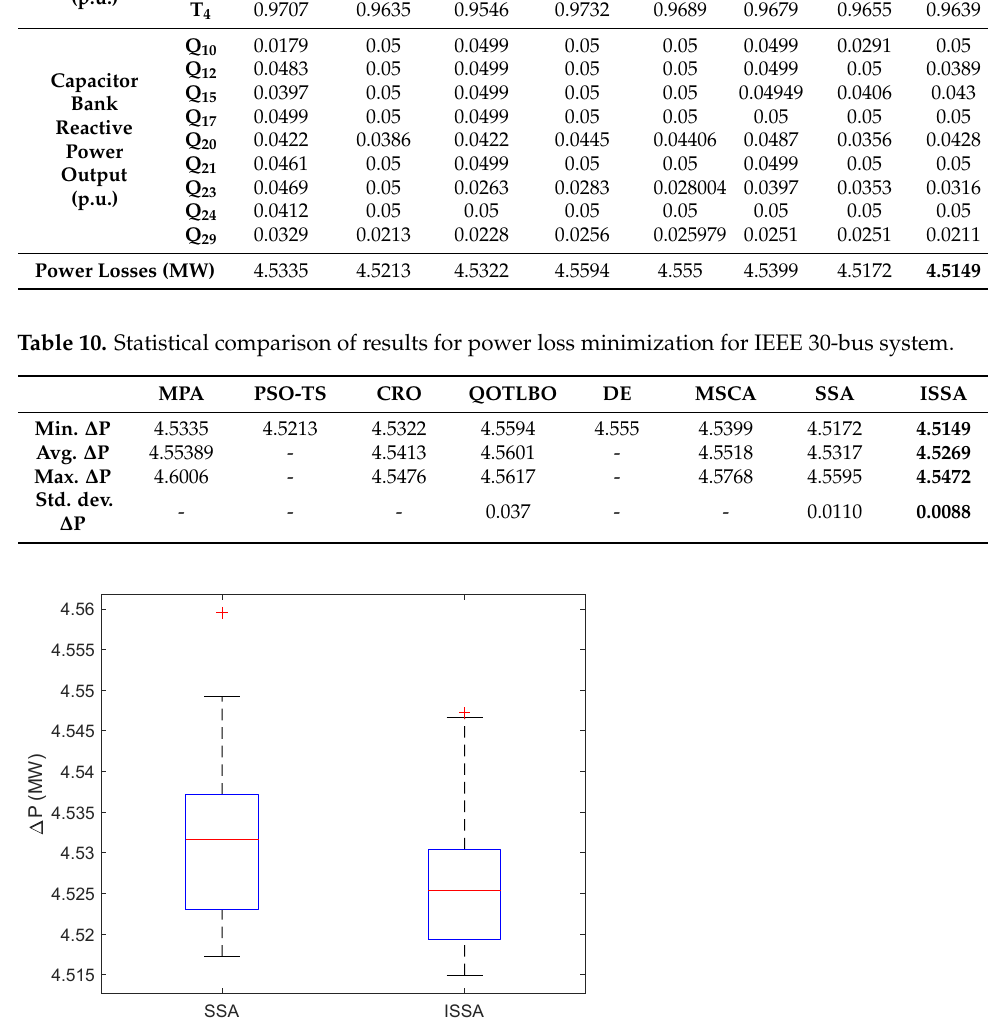
Figure 5. Boxplots of SSA and ISSA for power losses minimization for IEEE 30-bus system. Voltage Deviation (VD) Minimization